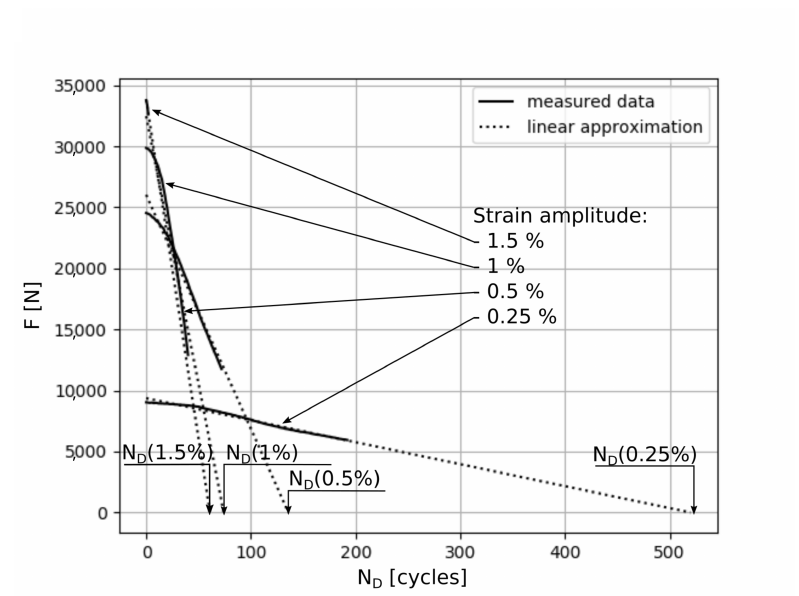
Figure 7. Specimens’ number of cycles to failure N D from stable response to complete rupture. Each curve corresponds to a specific (cid:101) a loading regime.